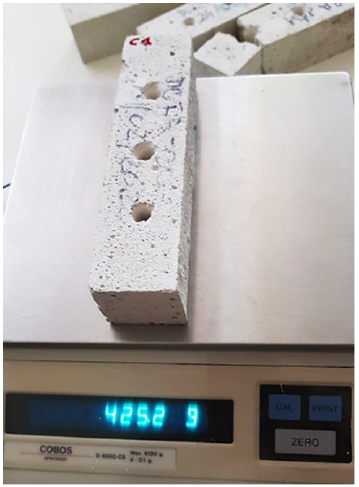
Figure 4. Weighing of the drilled sample in lime mortar.